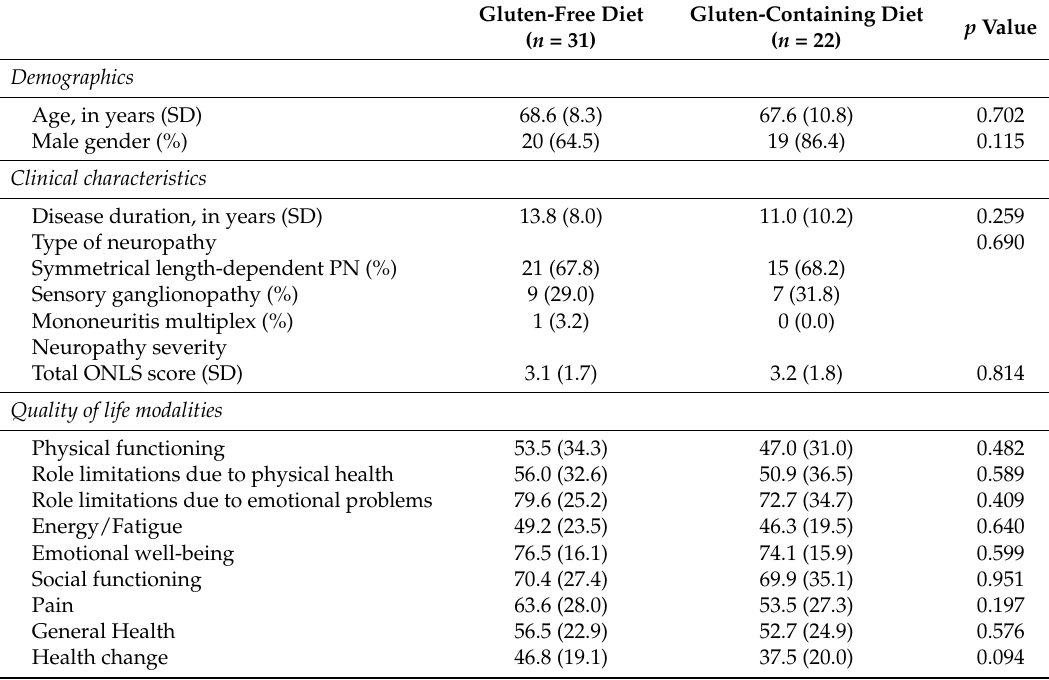
Table 2. Demographic, clinical, and quality-of-life-related characteristics of patients with gluten neuropathy reporting being on a gluten-free diet (GFD) compared to patients with gluten neuropathy reporting being on a gluten-containing